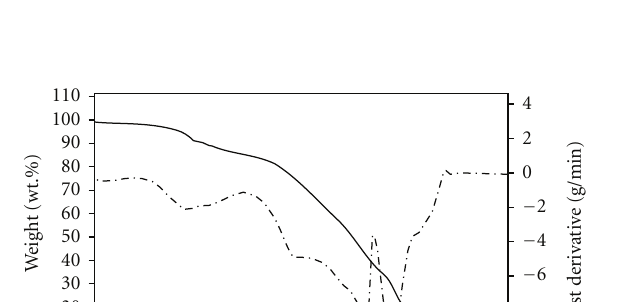
at 1750–1660 and 1406–1380 cm − 1 showing